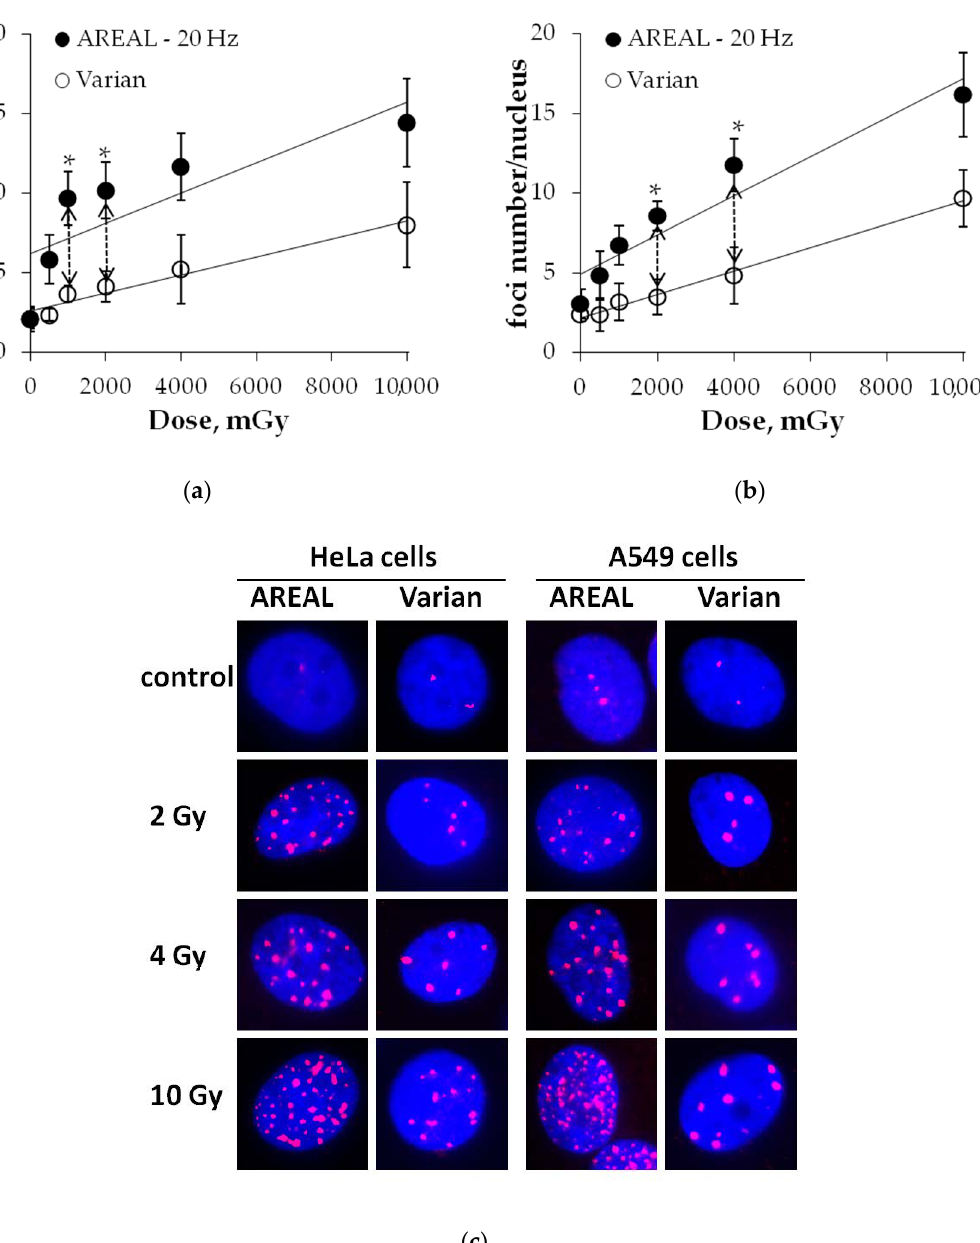
Figure 4. Dose-dependent changes in the γ H2AX residual foci numbers in HeLa ( a ) and A549 ( b ) cells at 24 h post-irradiation by AREAL (ultrashort pulsed 3.6 MeV electron beams) and Varian (quasi-continuous 4.0 MeV electron beams) accelerators; ( c ) representative images of residual γ H2AX foci in cell nuclei. Nuclei were counter-stained with DAPI, shown in blue. γ H2AX foci are shown in red. Mean values derived from at least three independent experiments are shown. Error bars show SE. Statistical significance was tested using the Student t-test. * p value < 0.05.